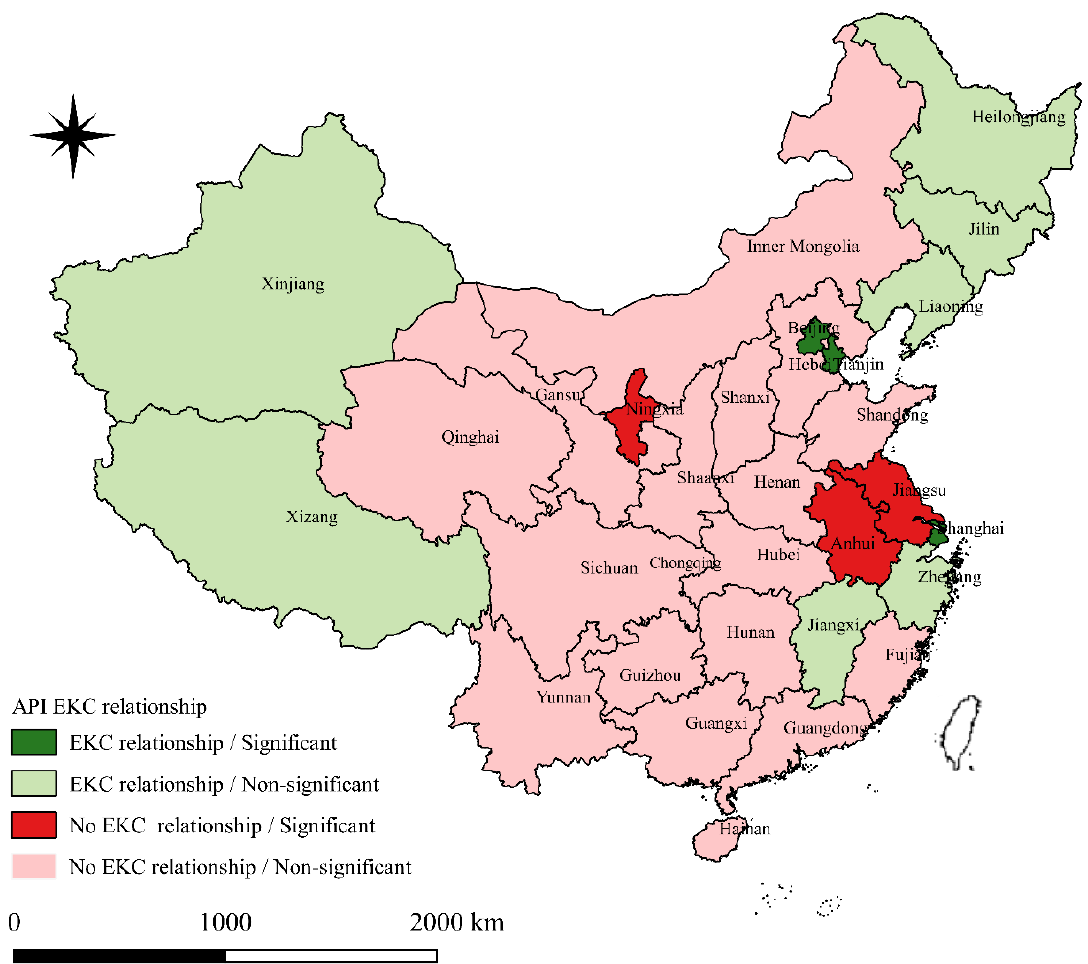
Figure 1. EKC for the haze in China.